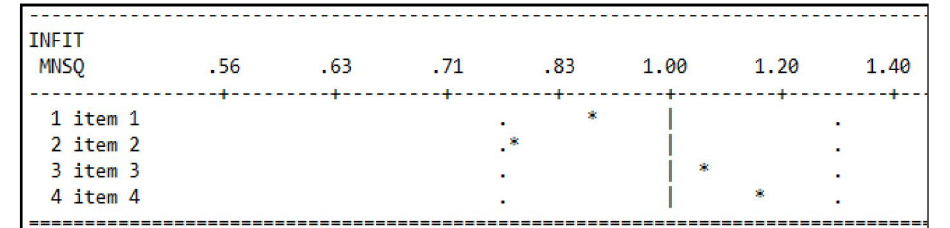
Figure 4. Result of analysis of item fitness of mathematical representation ability